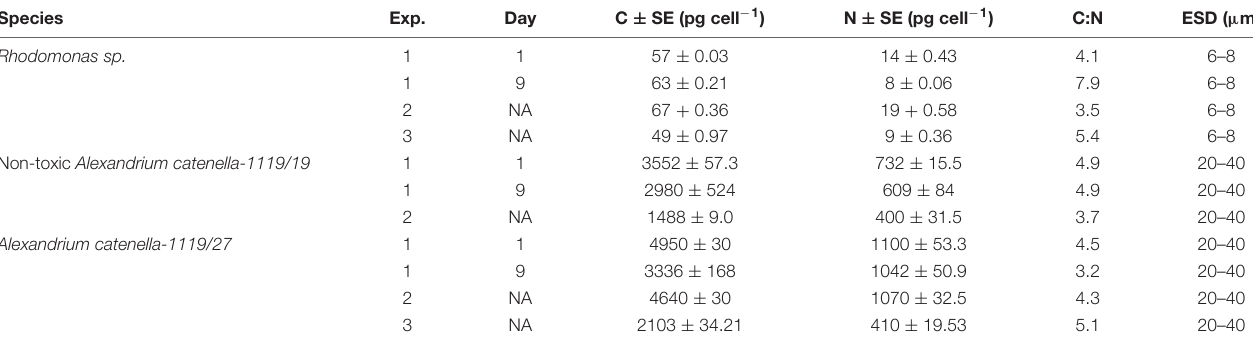
TABLE 2 | Alexandrium catenella (1119/27-Loch Ainort) toxin profile concentrations (fmol cell − 1 ). (A) Toxin concentration, fmol cell − 1